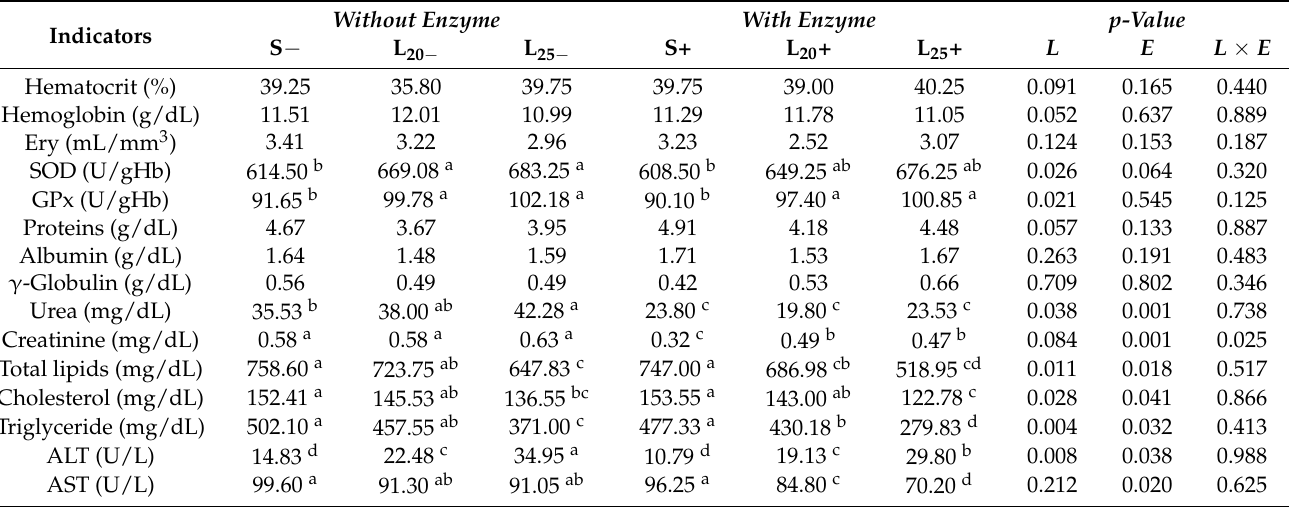
Table 5. Influence of enzymes addition in lupine-based diets on the blood biochemical parameters of